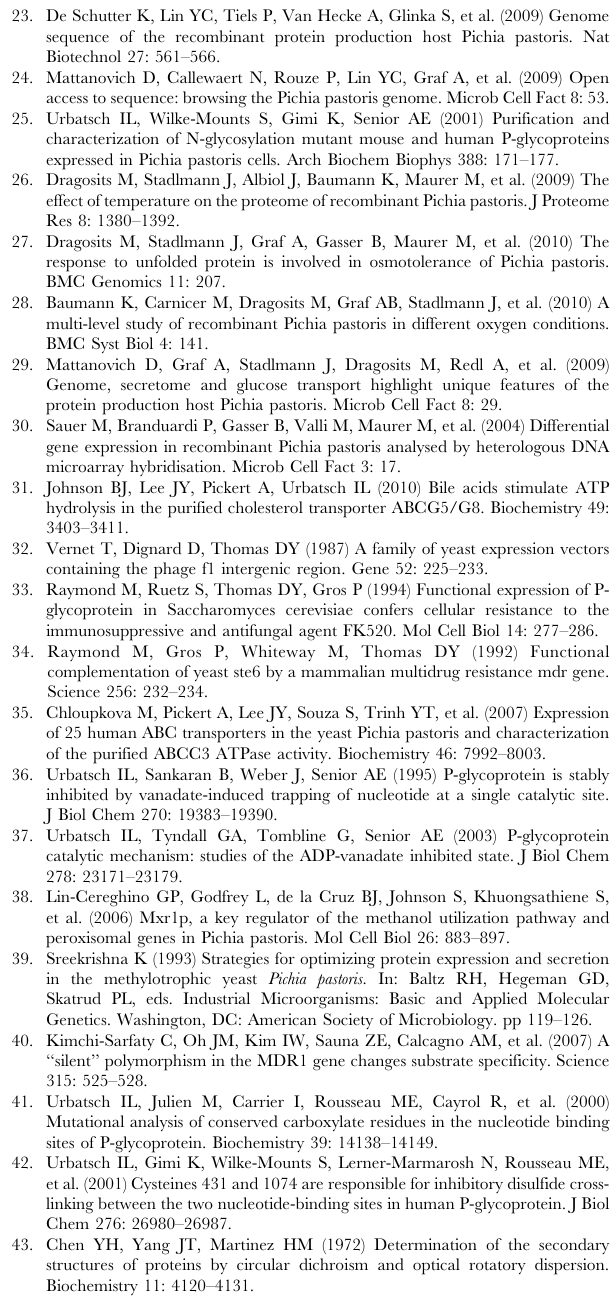
plasmid encodes a protein bearing a C-terminal His 6 tag. In addition, the vector contains Kozak-like bases in the region around the ATG start codon (positions -3 and + 1) important for high-level expression in P. pastoris [31]. Integrity of the CDS was confirmed by DNA sequencing. The resulting plasmids pLIC- mdr3 -H 6 and pLIC- opti-mdr3 -H 6 were transformed into P. pastoris strain KM71H and selected on 100 m g/ml Zeocin as described [35]. Figure S3 Amino acid and nucleotide sequence align- ment of wild-type mdr3 and